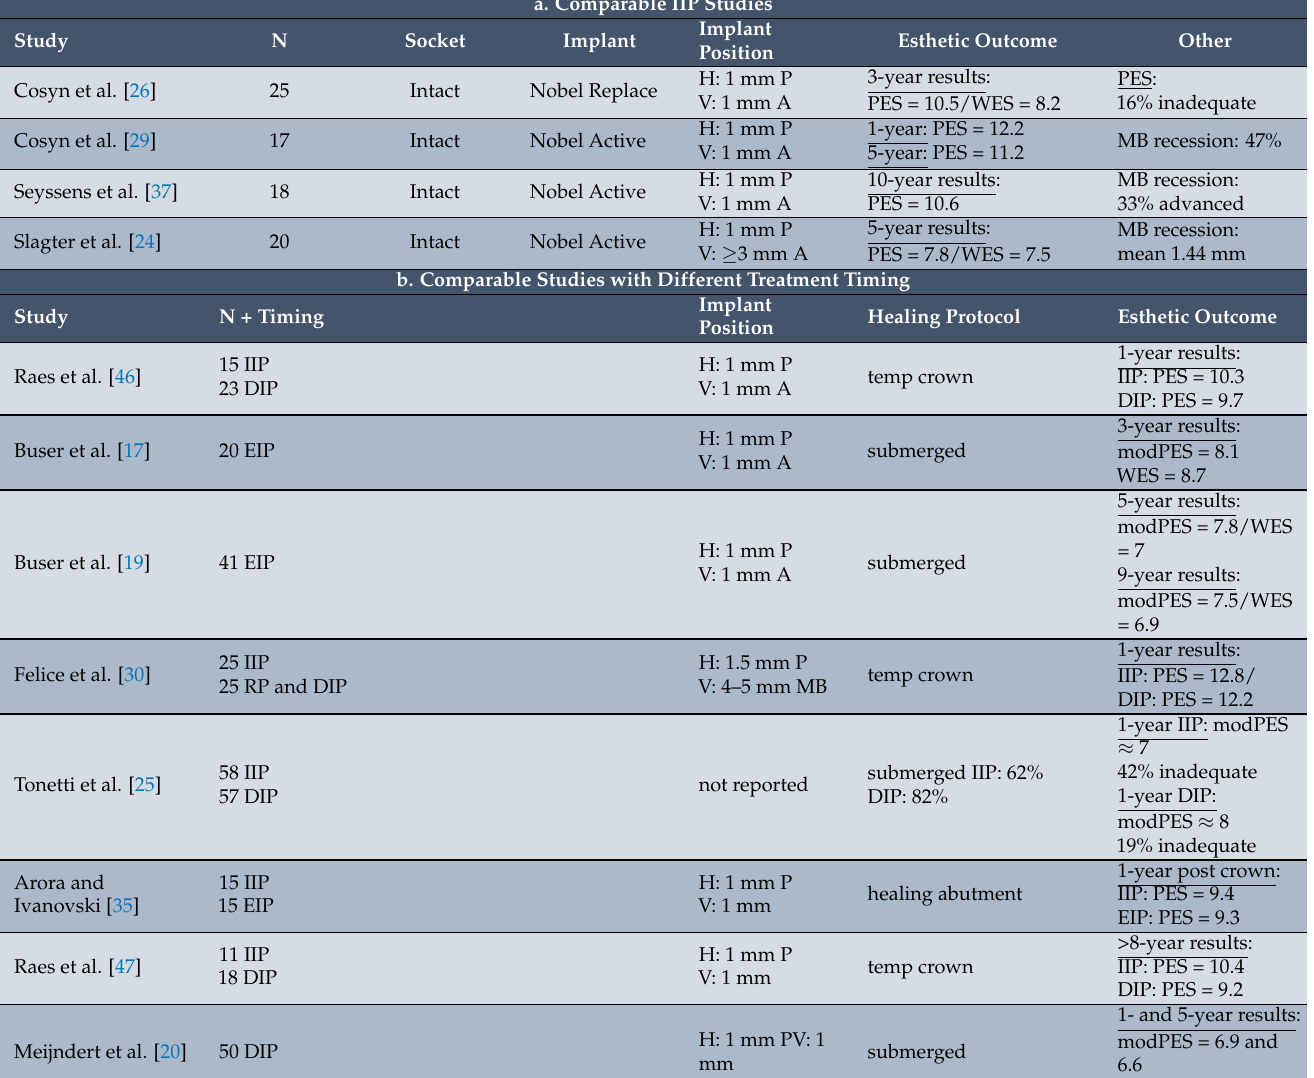
Table 5. (a) Prospective esthetic outcomes of four IIP studies, using Bio-Oss™ as a filler of the socket. Except of the study of Cosyn et al. [26], a flapless protocol was followed combined with immediate loading. (b) Prospective esthetic outcomes on single maxillary tooth replacements performing various protocols: IIP, EIP, and DIP. contrast of to EIP/DIP protocols, the IIP protocols followed a flapless approach, except for Tonetti et al. [25], who performed primary closure of the socket in IIP. Except for Raes et al. [46,47], bone (substitute) and a membrane were used in all